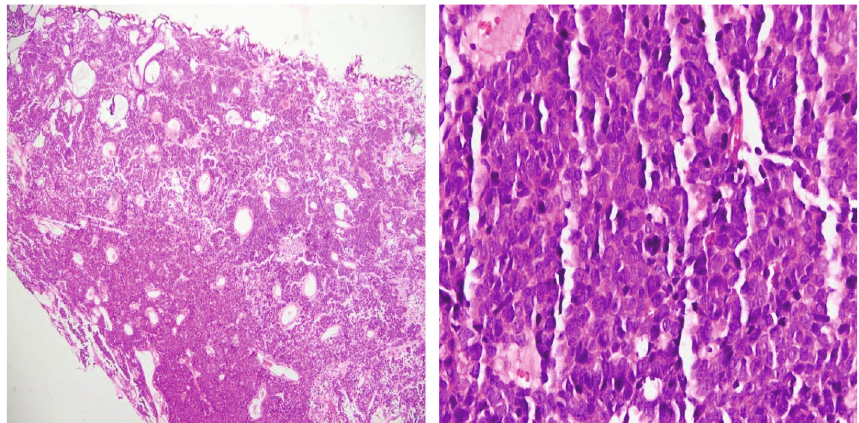
Figure 2: On the left: microscopic view of the bladder biopsy showing a proliferation of polygonal malignant cells and cylindrical cells with multiple necrotic areas; on the right: large polygonal cells with a dark and irregular nucleus and frequent